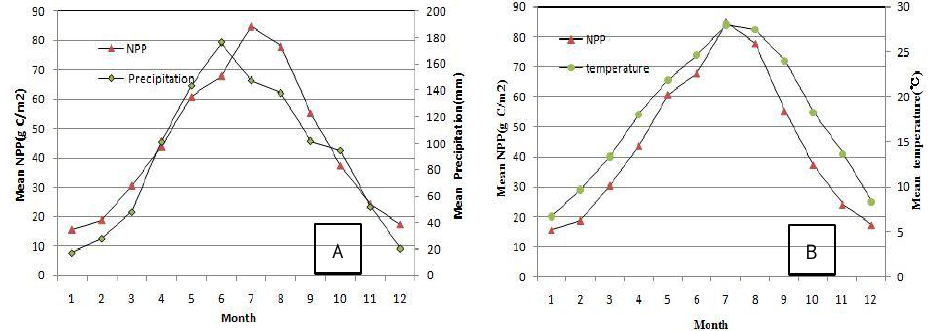
Figure 11. Monthly changes of estimated NPP and precipitation (A), temperature (B) (from 2001 to 2011).